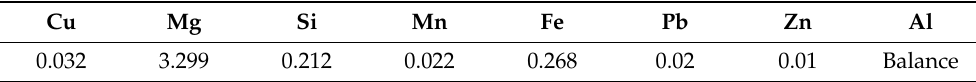
Table 1. Chemical composition of LM5 aluminum alloy.